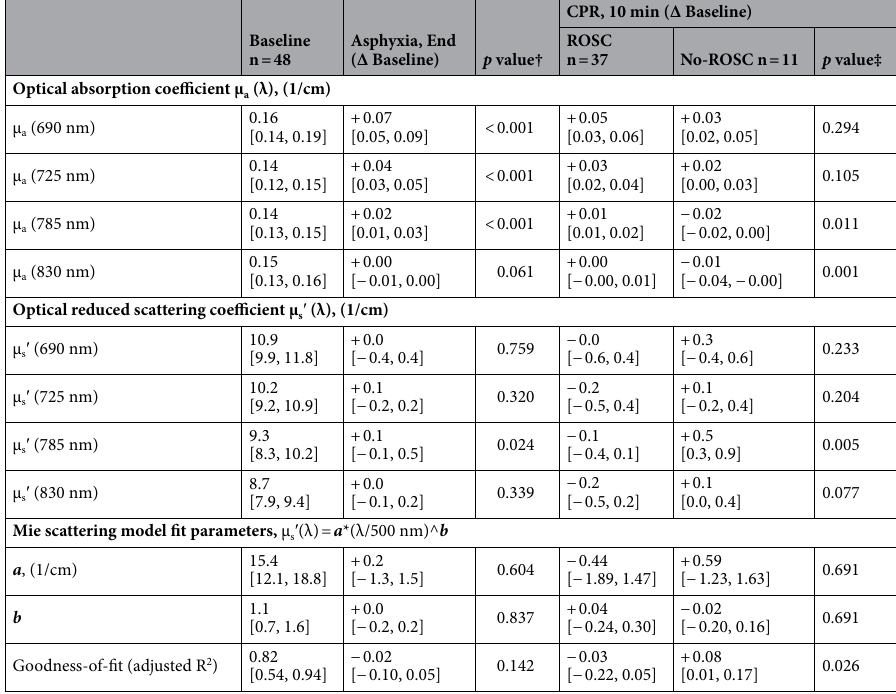
Table 1. Summary of optical absorption and scattering properties at baseline, end-of-asphyxia and 10-min of CPR. Values summarized as median [IQR]. † p value from Wilcoxon signed-rank test. ‡ p value from Wilcoxon rank-sum test comparing ROSC and No-ROSC groups. λ, wavelength; Δ Baseline, change from Baseline; ROSC, return of spontaneous circulation; a , fitted reduced scattering coefficient at λ = 500 nm; b , scattering